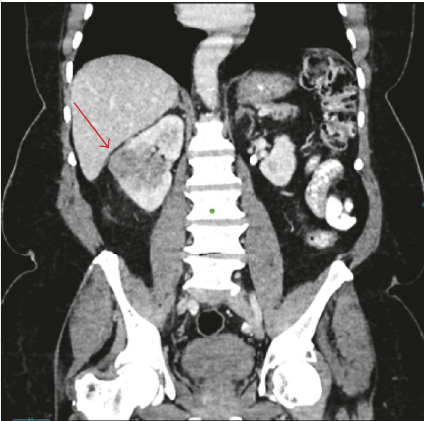
Figure 3: Right kidney with attached ureter showing tumour arising from the renal pelvis projecting into the proximal ureter and infiltrating the renal parenchyma.